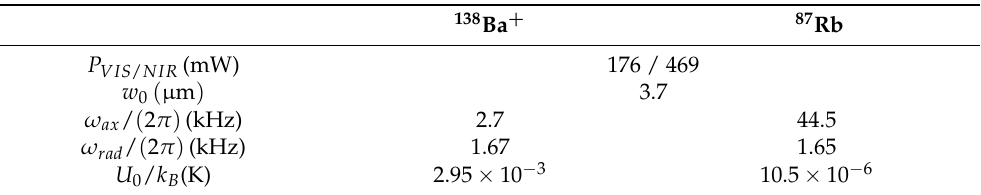
Table 2. Properties of the calculated bichromatic potentials for an adapted configuration based on the setup shown in Figure